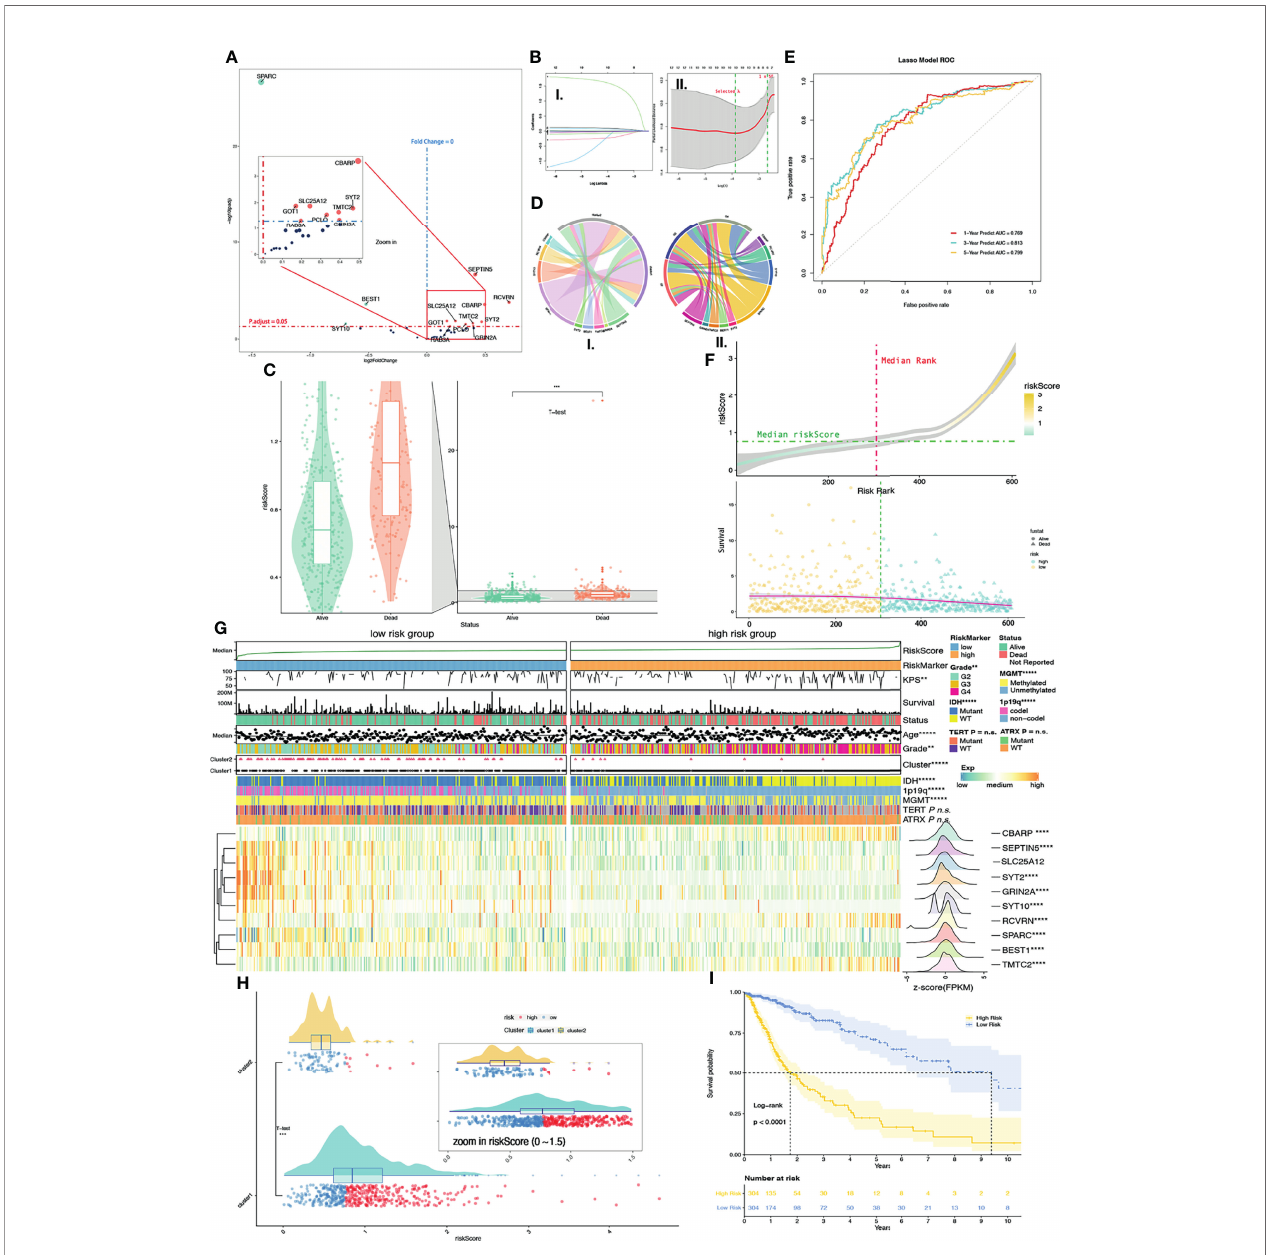
FIGURE 4 | Supervised learning of DEGs in CKGs between Cluster 1/2. (A) 13 DEGs were found in CKGs between Cluster 1/2 (p.adjust < 0.05). Upregulated genes were marked in red color, and downregulated genes were marked in green color. (B) Supervised learning with Lasso – Cox arithmetic (I.) and (II.) l was selected when partial likelihood deviance came to smallest (II. left green line). (C) Diagram of survival outcomes with risk score (p < 0.001). (D) Mean expression values of DEGs in calcium hub genes (CHGs) between high/low-risk groups (I.) and among glioma grades (II.). (E) ROC curve showed the predictive ef fi ciency of the 1/3/5-year survival rate on risk score (1-year AUC = 0.769, 2-year AUC = 0.813, 3-year AUC = 0.799). (F) Distribution of risk score with risk rank (upper plot) and overall survival (lower plot). (G) The heatmap shows the expression levels of the CHGs in low/high-risk groups and the signi fi cantly (p < 0.05) changed gene was marked. The distribution of clinical features was compared between the low-risk and high-risk groups. (H) Risk score levels with Cluster 1/2. (I) Kaplan – Meier overall survival curves for high/low-risk groups. Log-rank test, p < 0.0001. n.s. p ≥ 0.05, **p < 0.01, ***p < 0.001, ****p < 0.0001, and *****p <